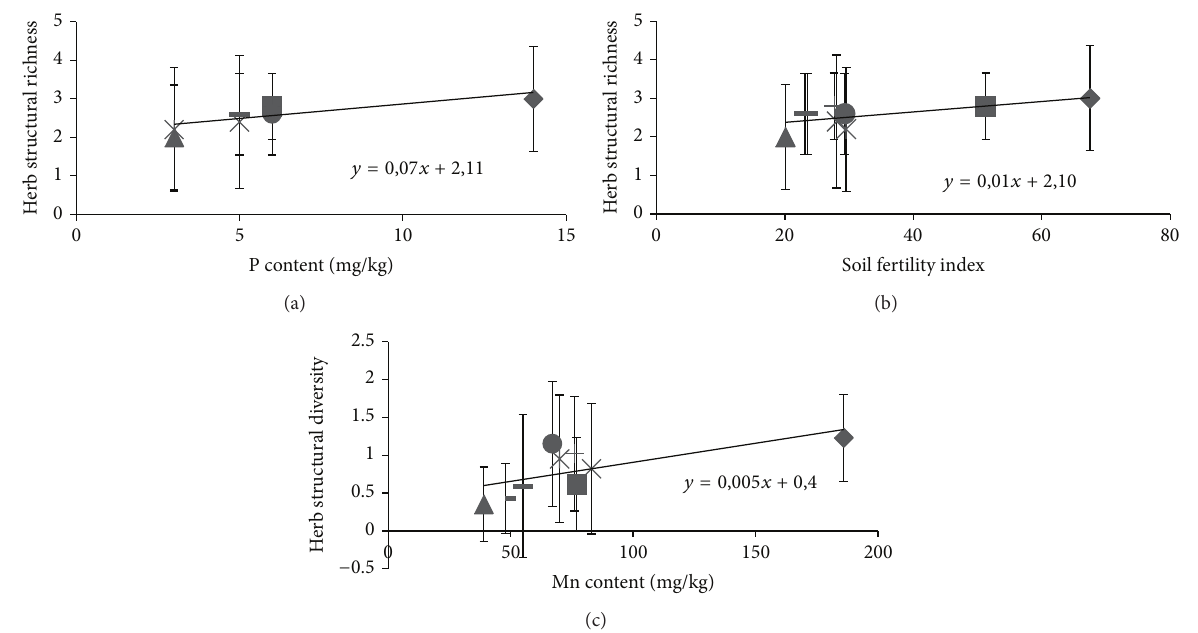
Figure 4: Linear regression relationships between (a) herb structural richness and P content (mg/kg), (b) herb structural richness and soil fertility index, and (c) herb structural diversity and Mn content (mg/kg).